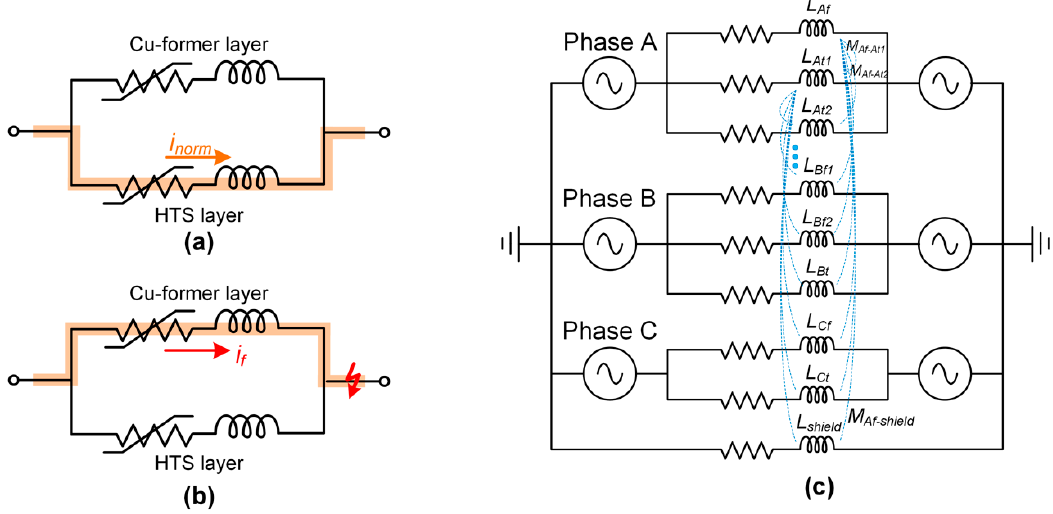
Figure 2. Operation characteristic and equivalent scheme of co-axial HTS cable adopted from [21]: ( a ) current flow into each phase in the normal state; ( b ) current flow into each phase in the transient state; ( c ) equivalent circuit of the HTS power